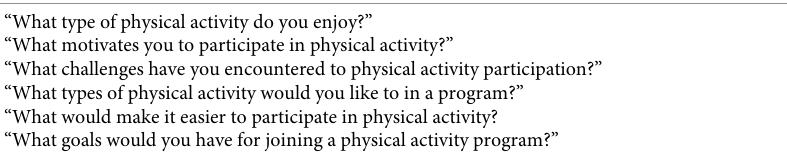
Table 2. Open ended interview